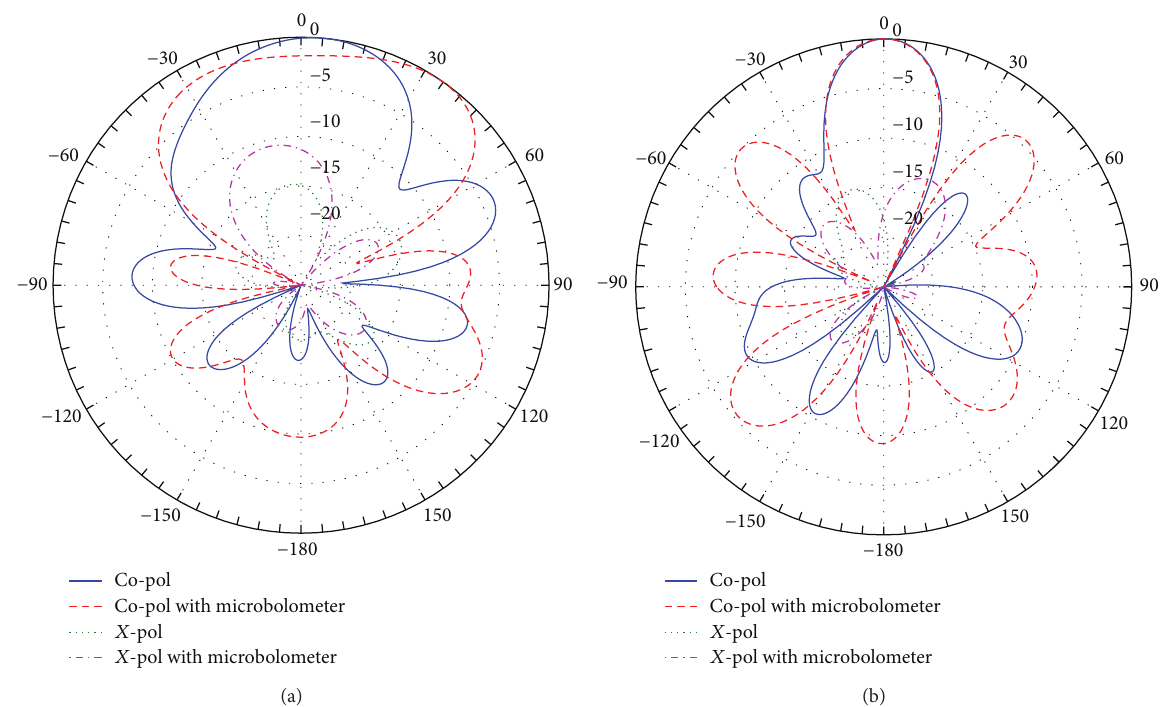
Figure 9: Simulated copolarization and cross-polarization radiation patterns in (a) 𝑌𝑍 plane and (b) 𝑋𝑌 plane at 𝑓 = 94 GHz for the Quasi- Yagi dipole array antenna prototype II with and without microbolometer.